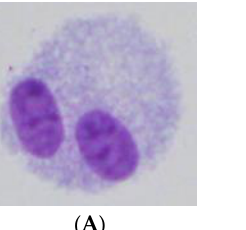
Figure 6. Representative images of micronuclei formation. ( A ) Unirradiated binucleated CHO cell without micronuclei. ( B ) 6 Gy of gamma-ray irradiated binucleated CHO cell with a micronucleus. The arrow indicates the micronucleus.